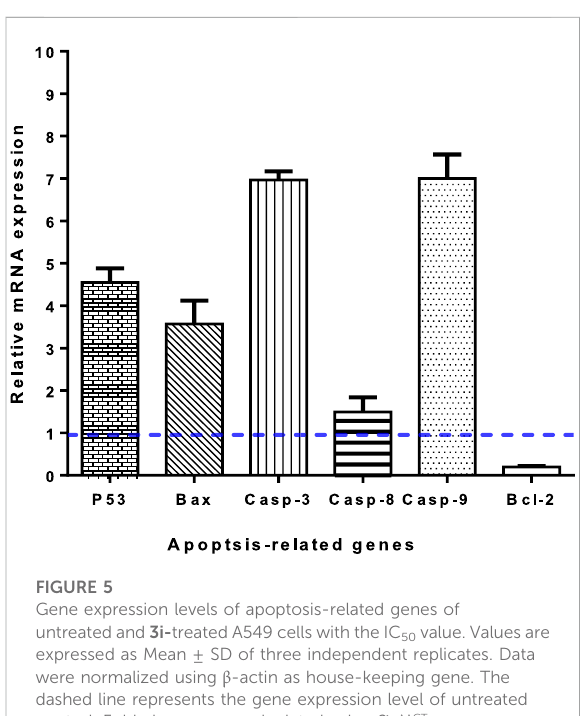
FIGURE 5 Gene expression levels of apoptosis-related genes of untreated and 3i- treated A549 cells with the IC 50 value. Values are expressed as Mean ± SD of three independent replicates. Data were normalized using β -actin as house-keeping gene. The dashed line represents the gene expression level of untreated control. Fold change was calculated using 2 ^ - ΔΔ